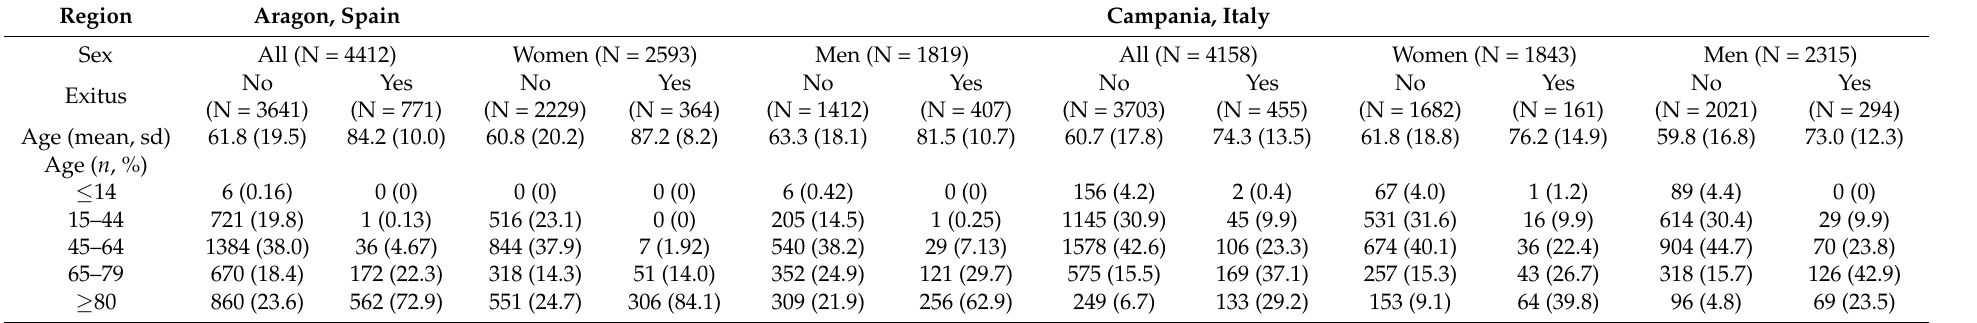
Table 1. Demographic characteristics of the study population, by region and follow-up status (i.e., exitus no/yes).